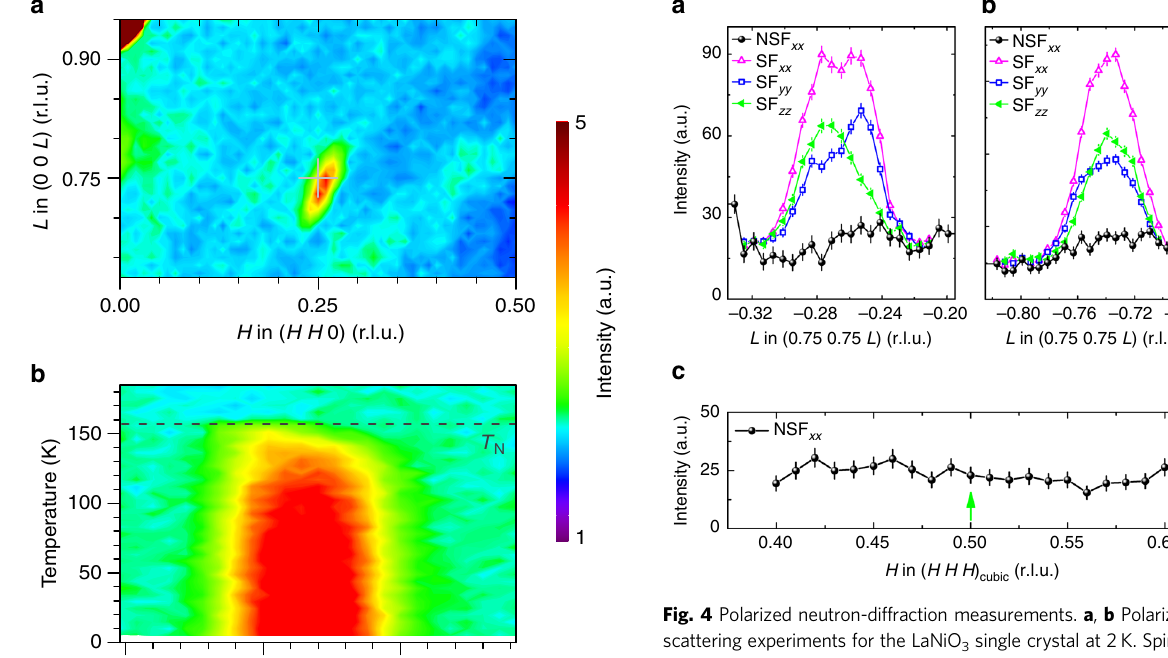
Fig. 2a — the pseudocubic propagation vector for rhombohedral LaNiO 3 is the same as the pseudocubic propagation vector for the orthorhombic insulating nickelates R NiO 3 ( R = Pr-Lu, Y). Based